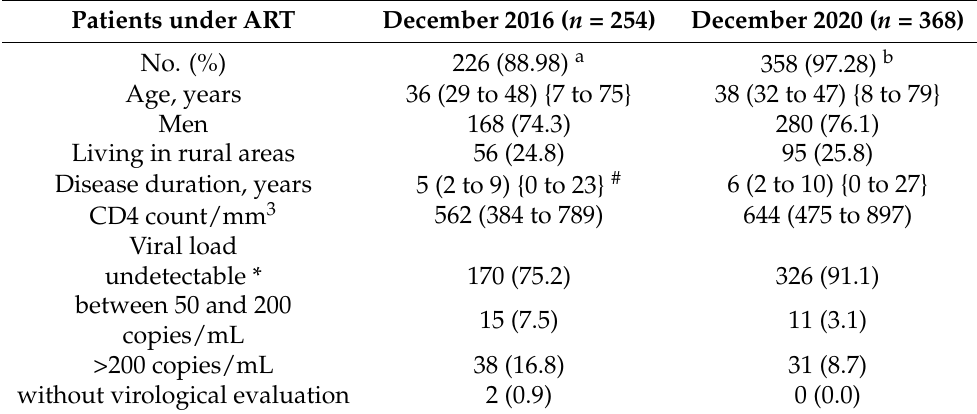
Table 2. HIV patients: demographics and viral load.